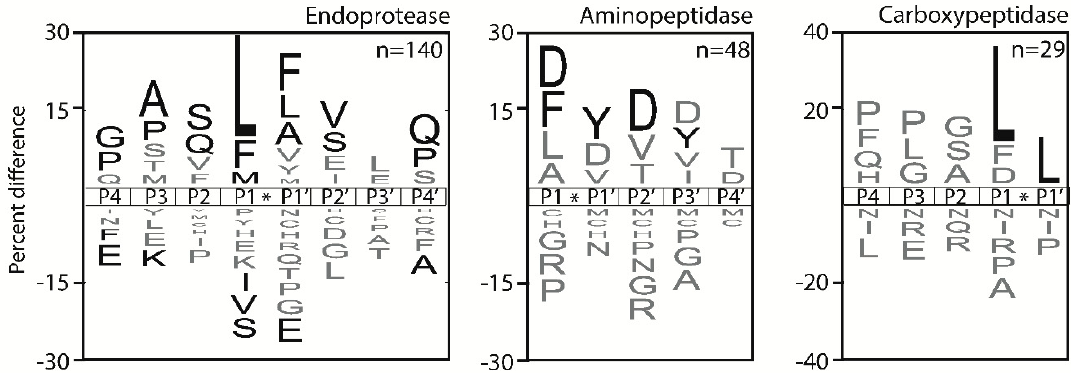
Figure 4. Relative percentage of forms deriving from endopeptidase (light gray) or endopeptidase followed by exopeptidase (dark gray) forms of the peptides undergoing endo- and exopeptidase cleavages listed in Table S2.